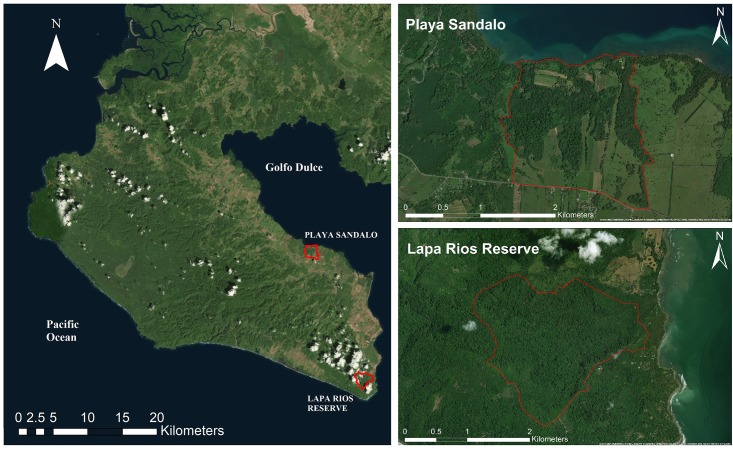
Study sites within the Osa Peninsula (Map Data: Esri, Digital Globe, GeoEye, Earthstar Geographics, CNES/Airbus, DS, USDA, USGS, AeroGRID, IGN, and GIS User Community).The Lapa Rios Reserve and Playa Sandalo property boundaries are highlighted with red marker lines. Depicted boundaries were created by this study using spatial features (i.e. roads and forest edges). Lapa Rios located within the GDFR (i.e. biological corridor), under strict conservation status since 1990s and serving as pseudo control group to compare with Playa Sandalo area. The later impacted by urban and agricultural development including multiple private land owners without legal protection status.